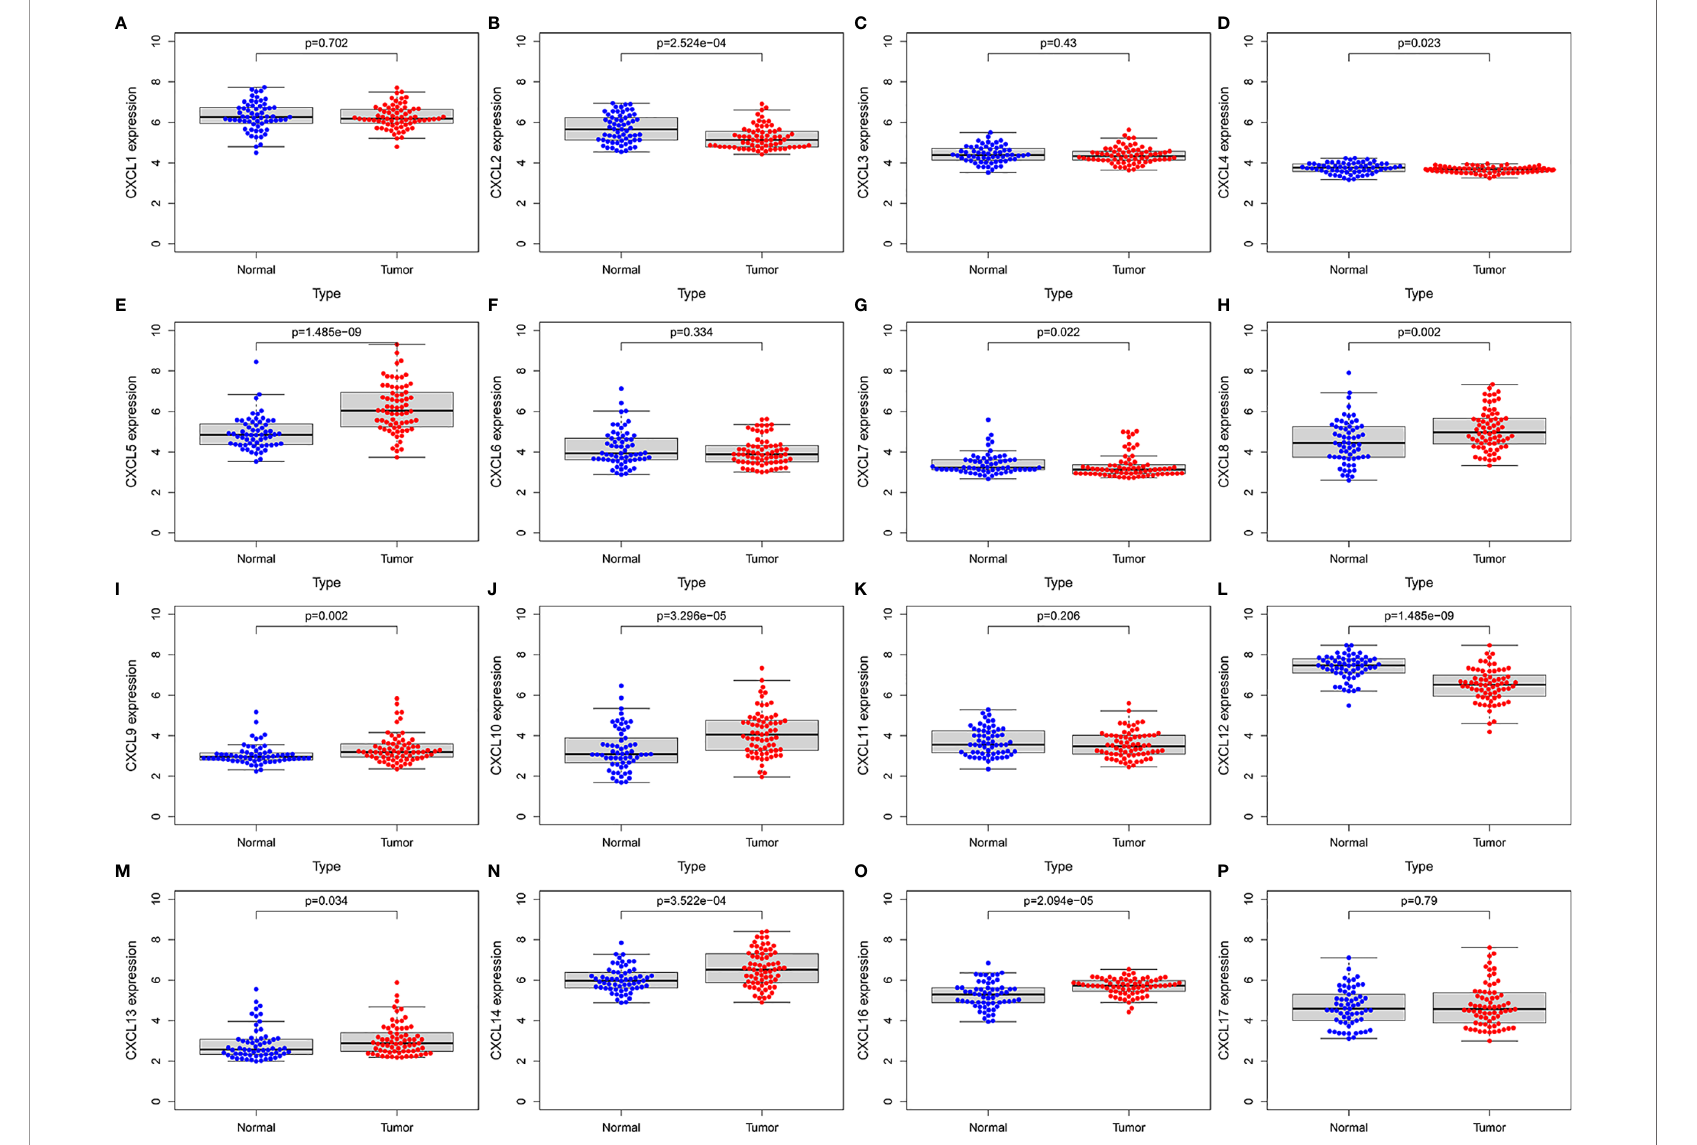
FIGURE 13 | External validation of the expression levels of CXC chemokines in independent GSE62452 cohort (GEO database). (A) CXCL1 (B) CXCL2 (C) CXCL3 (D) CXCL4 (E) CXCL5 (F) CXCL6 (G) CXCL7 (H) CXCL8 (I) CXCL9 (J) CXCL10 (K) CXCL11 (L) CXCL12 (M) CXCL13 (N) CXCL14 (O) CXCL16 (P)